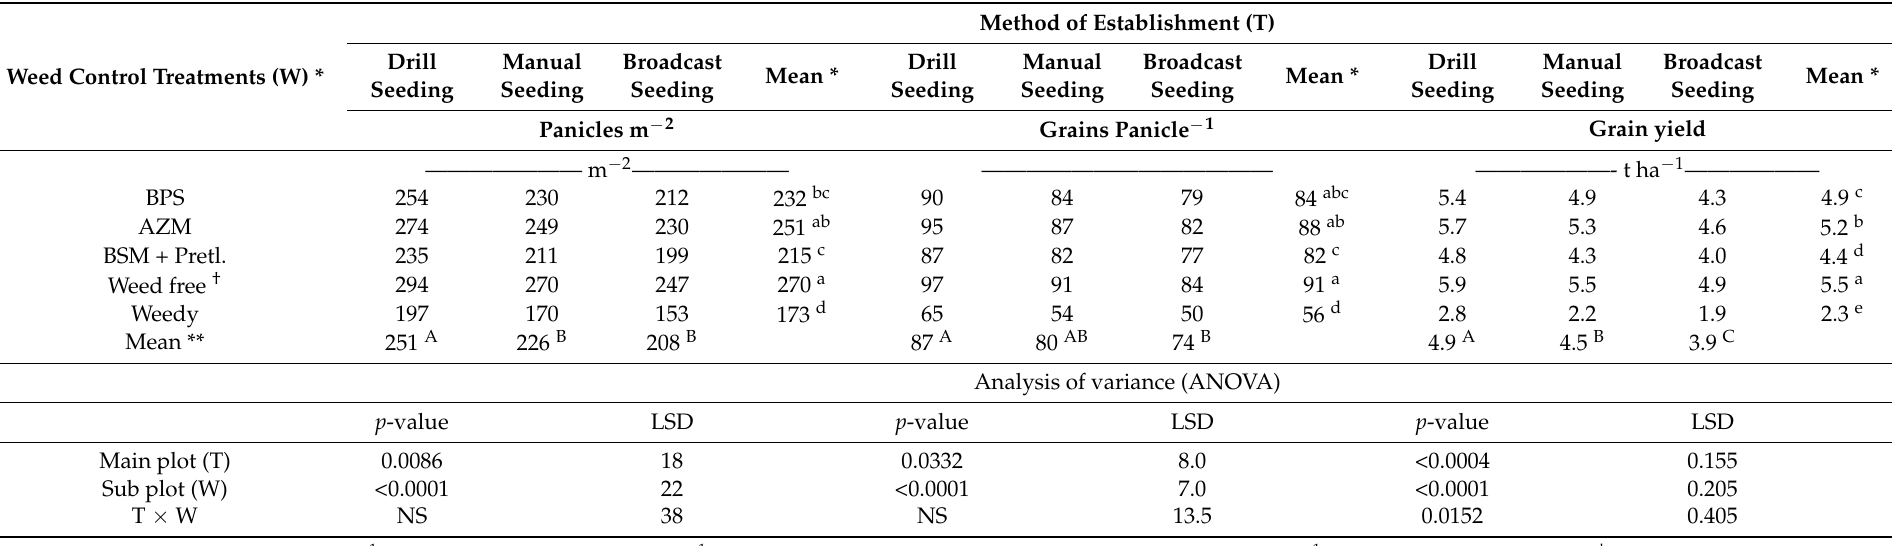
Table 4. Effect of establishment methods and weed control treatments on yield components and grain yield of rice (Average of 2015 and 2016) § .